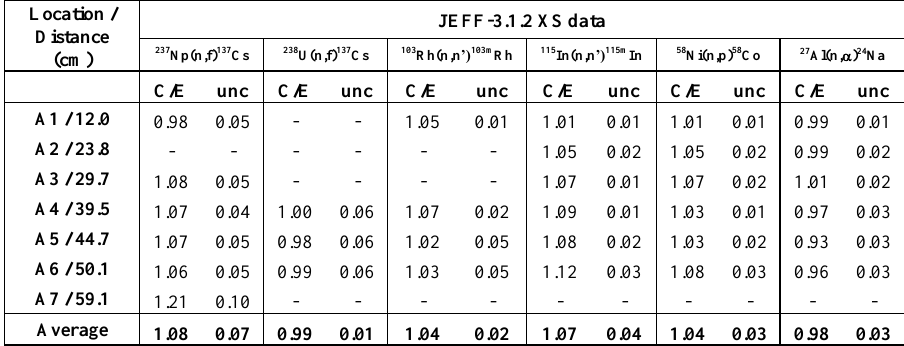
Table 4 : C/E specific activity ratios for the PCA benchmark problem. Uncertainties of averages are based on observed sample standard deviations only. Transport XS data from JEFF-3.1.2.